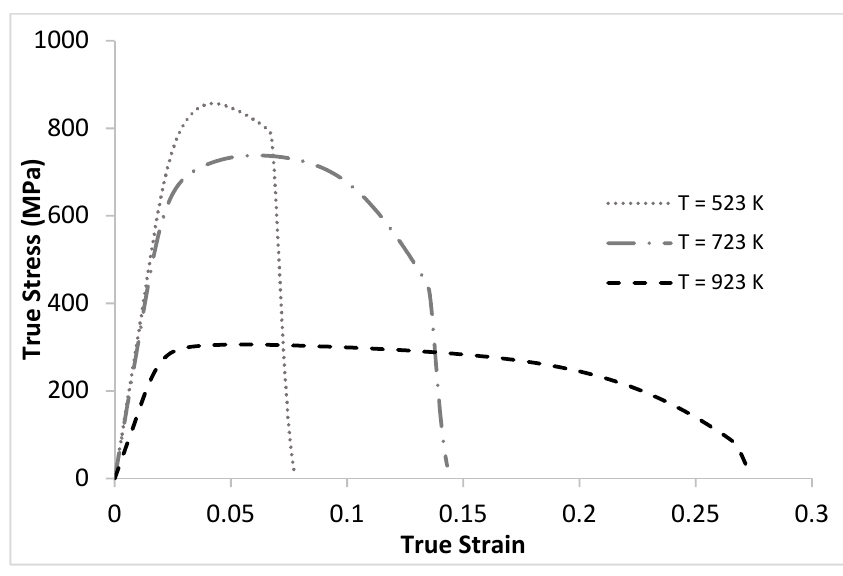
Figure 4. True stress-strain curves at high temperatures at a strain rate of 0.15 s − 1 .